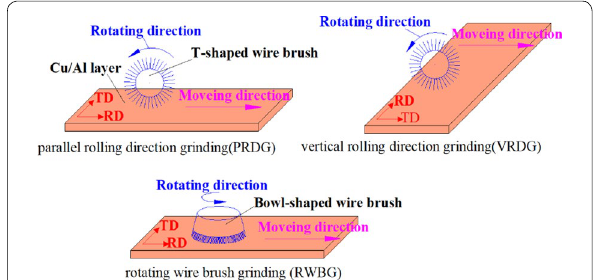
Fig. 1 Schematic of different mechanical surface